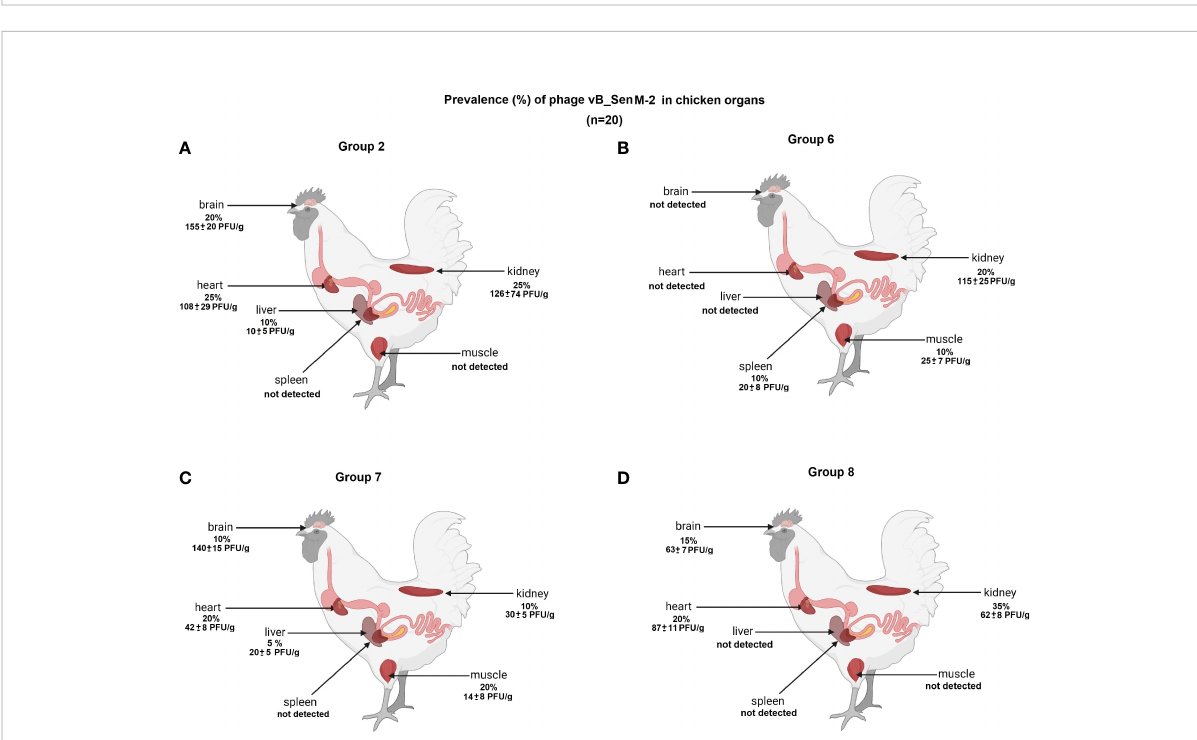
FIGURE 8 Presence of phage vB_SenM-2 (percent of chickens in which phages were detected is indicated; 100% = 25) in chicken organs in Groups 2 (A) , 6 (B) , 7 (C) and 8 (D) . The values represent mean phage titers (PFU/g) with